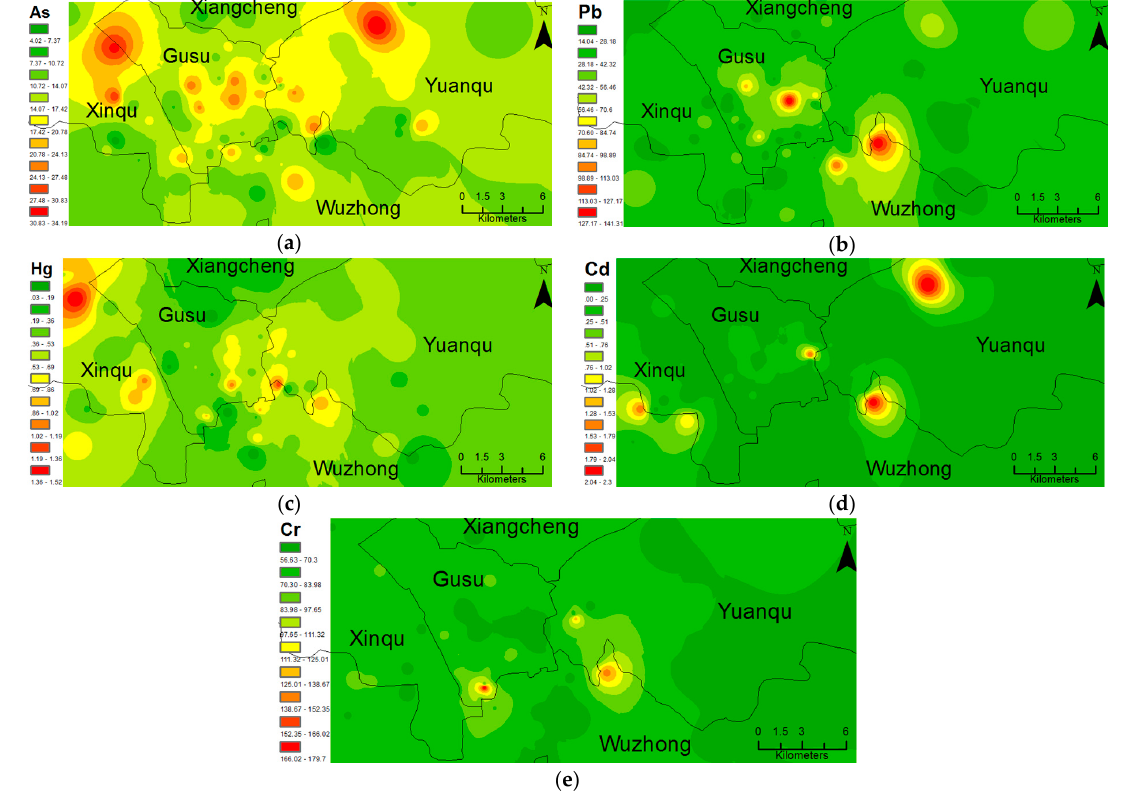
Figure 2. The spatial variation of As ( a ), Pb ( b ), Hg ( c ), Cd ( d ), Cr ( e ) pollution in the soils of Suzhou.